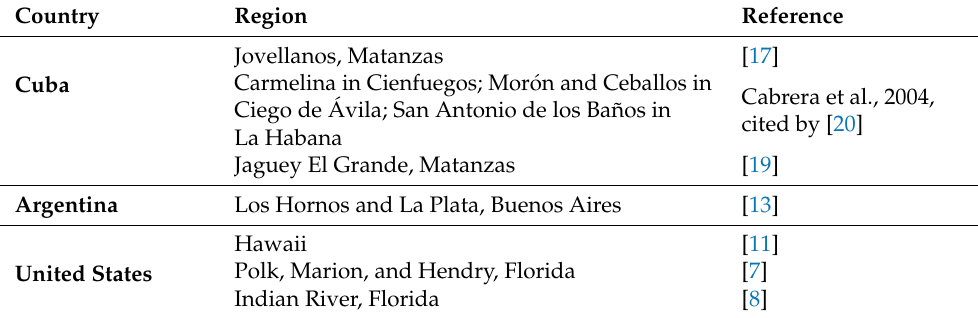
Table 2. Hirsutella citriformis geographic